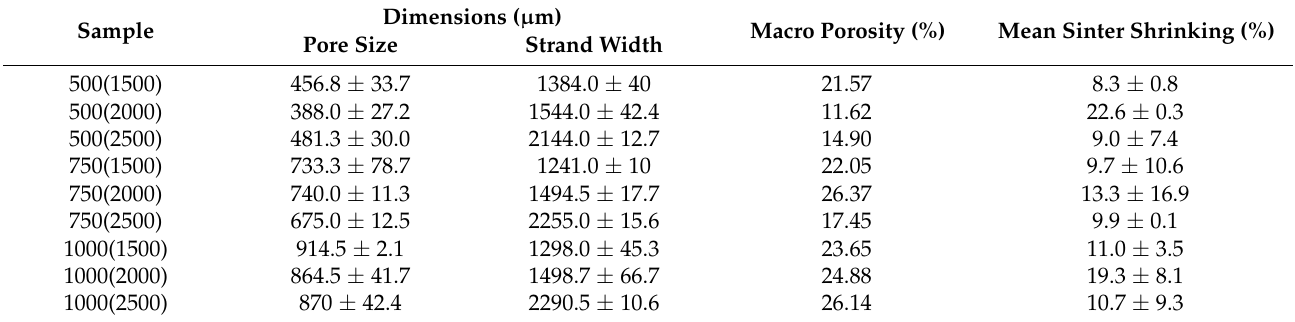
Table 4. Overview of pore size and strand widths of inverse printed 3D constructs.